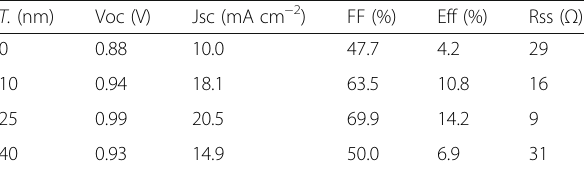
Table 1 Photovoltaic performance of inverted MAPbI3 solar cells with different thickness ( T. ) of CdSe QD layer T. (nm)